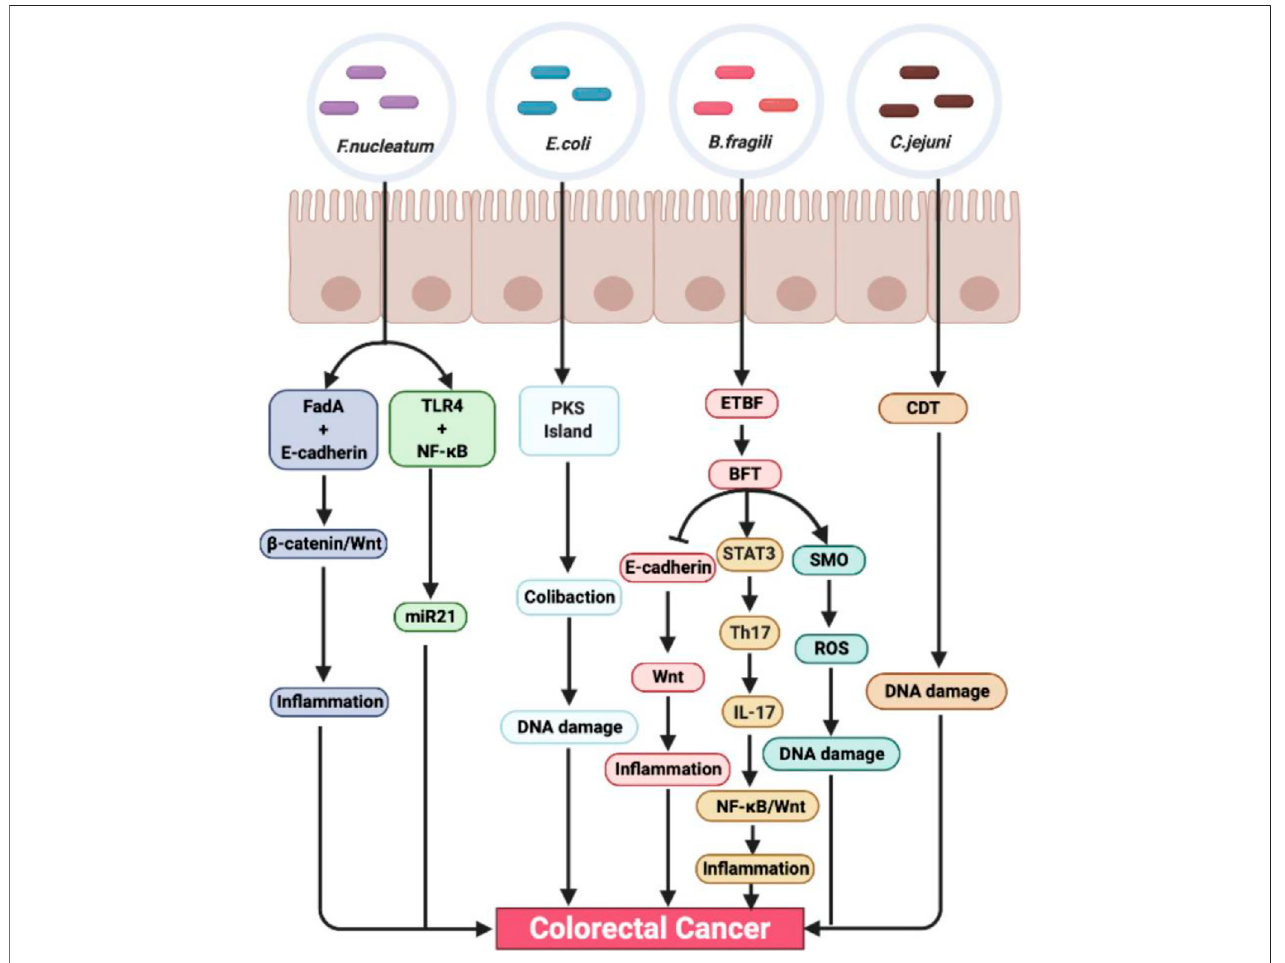
FIGURE 1 | The role and mechanism of intestinal microbiota promoting colorectal cancer. Fusobacterium nucleatum, E. coli, B. fragili, and C. jejuni are closely relatedtotheoccurrenceanddevelopmentofcolorectalcancer.Itcanstimulatein fl ammationandpromotetumorformationthroughmanyin fl ammation-relatedsignaling pathways, such as NF- κ B, STAT3, and Wnt/ β -catenin. At the same time, intestinal fl ora can also cause DNA damage, lead to gene mutation, and promote tumor formation through its own